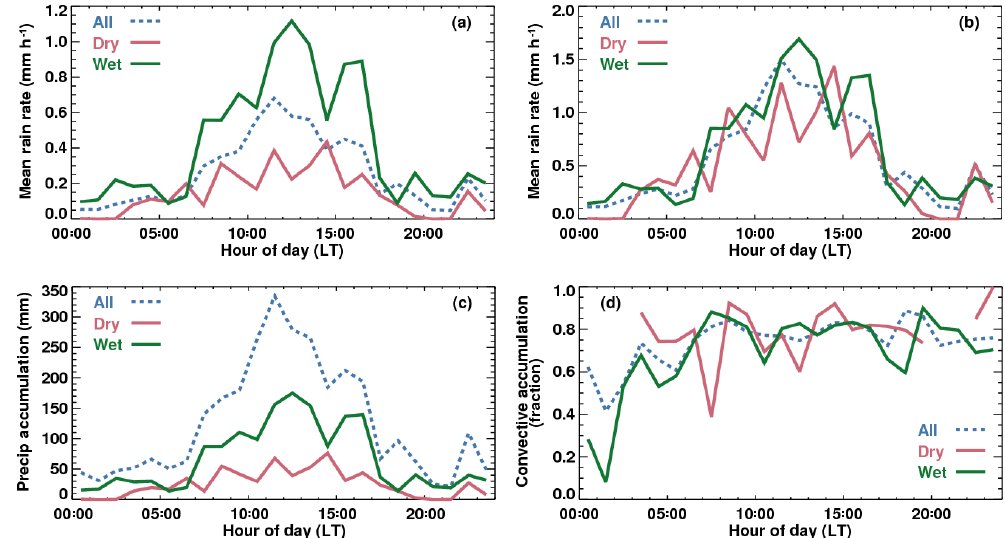
Figure 7. (a) Mean daily precipitation rate (mmh − 1 ) for all days and (b) for only the precipitating days during the campaign ( > 1mm). (c) The total accumulation in millimeters for the dataset and (d) the fractional convective accumulation as sampled by the rain gauges for the summary campaign and associated wet and dry season